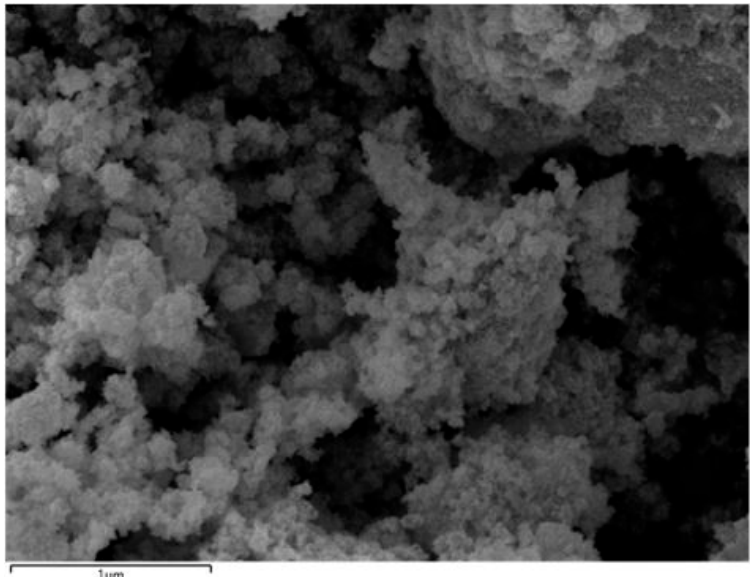
Figure 7. SEM micrograph of sample H-MW1. When temperatures higher than 500 ° C were used, the crystalline phase of spinel Co 0.5 Ni 0.5 FeCrO 4 can be observed with good crystallinity.